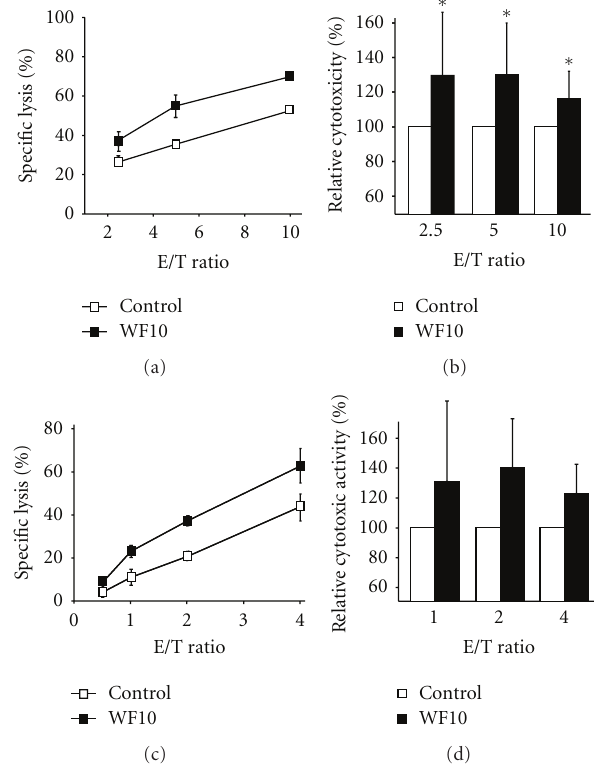
Figure 1: E ff ect of WF10 on the cytotoxic activity of NK cells. (a, b) Freshly isolated resting human NK cells or (c, d) IL-2 stimulated NK cells were used in a standard 4 h 51 Cr-release assays against LCL721.221 target cells with or without the addition of 200 μ M WF10 at the indicated e ff ector to target (E/T) ratios. Panels (a) and (c) show the results of representative experiments. In panels (b) and (d) the activity of the WF10-treated cells is shown relative to the cytotoxic activity of control cells (set as 100%) as an average value from (b) 24 or (d) 3 independent experiments. The ratio of each outcome and its control was tested against a value of 1 (equality) by two-sided single-sample t -tests ( ∗ P < .